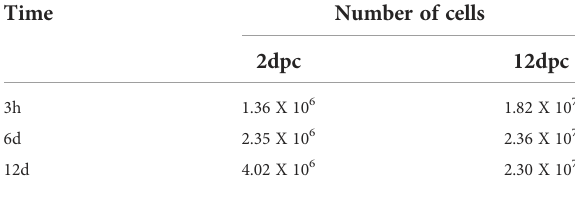
TABLE 2 Number of 3T3-L1 cells at different time-points at 2 and 12 dpc in MDI.